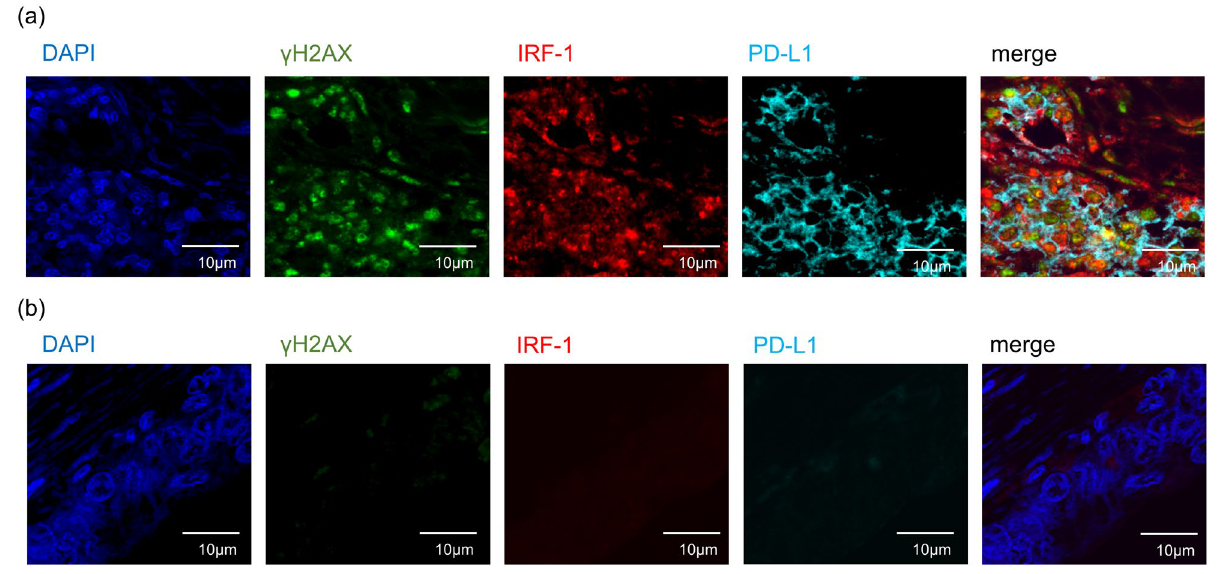
Figure 3. Immunofluorescence analysis for γH2AX, IRF-1, and PD-L1 expression in colitic cancer tissues. Colitic cancer tissues with high ( a ) or no ( b ) PD-L1 expression were immunostained with anti-γH2AX (green), anti-IRF-1 (red), and anti-PD-L1 (cyan) antibodies. All sections were counterstained with 4 ′ ,6-diamidino-2- phenylindole (DAPI) (blue). Scale bar, 10 μm (original magnification, ×60). γH2AX, H2A.X variant histone; IRF-1, interferon regulatory factor 1; PD-L1, programmed cell death ligand